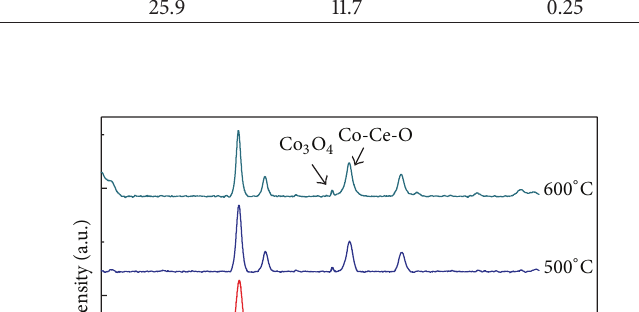
Table 3: Characteristic of Co